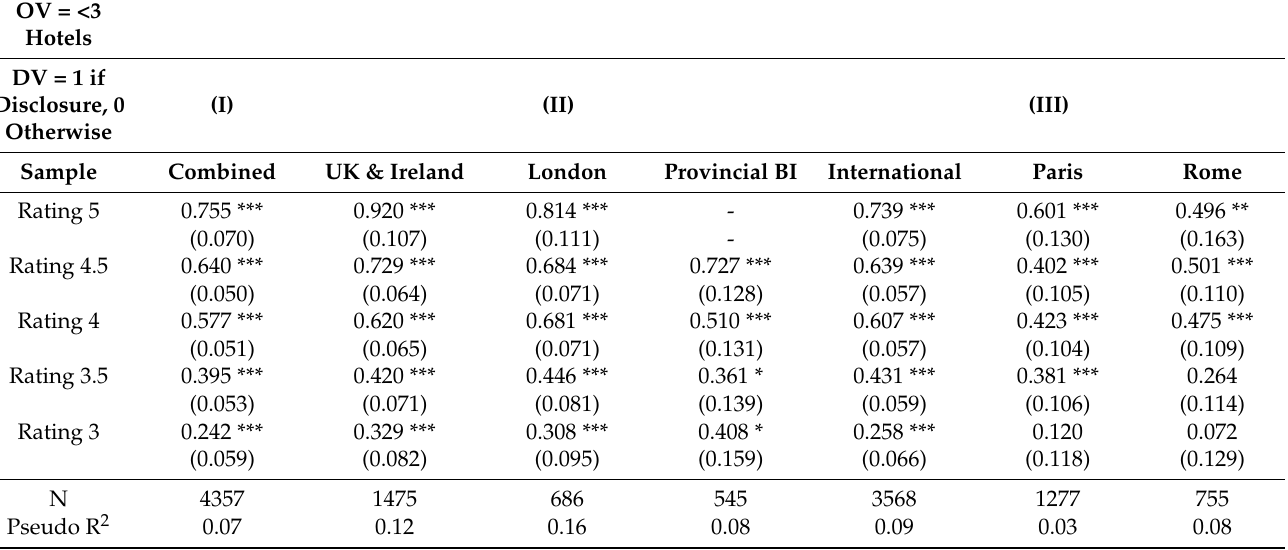
Table 5. Probit Results–Marginal